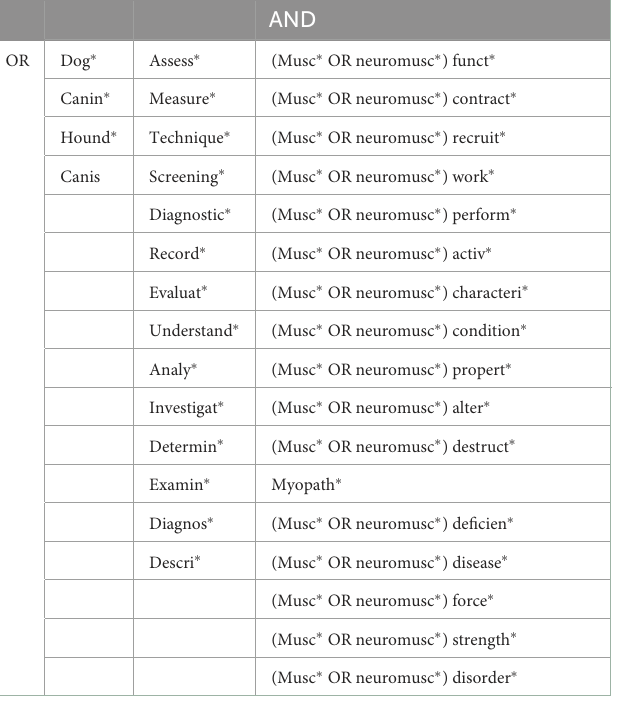
TABLE 1 Search strategy for the databases: Web of Science, CAB Abstracts, Ovid MEDLINE ® ALL, AGRICOLA, Scopus and Embase.